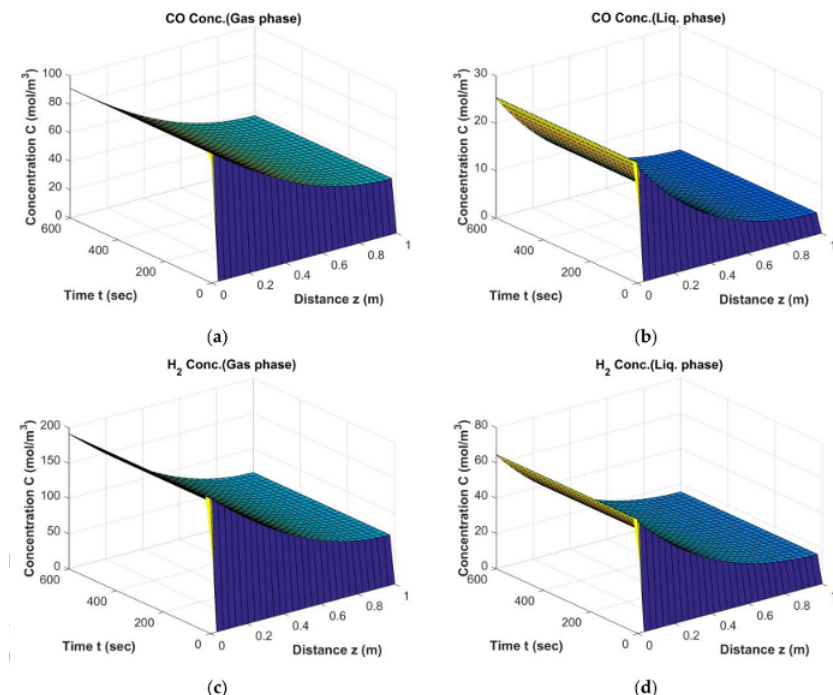
Figure 1. Results of Fischer–Tropsch (FT) Simulation; The behavior of CO, H 2 in gas phase ( a , c ) and liquid phase ( b , d ) from start-up to steady state conditions (D t = 0.1 m, H = 2.5 m, ε cat = 0.34, U g,in = 0.17